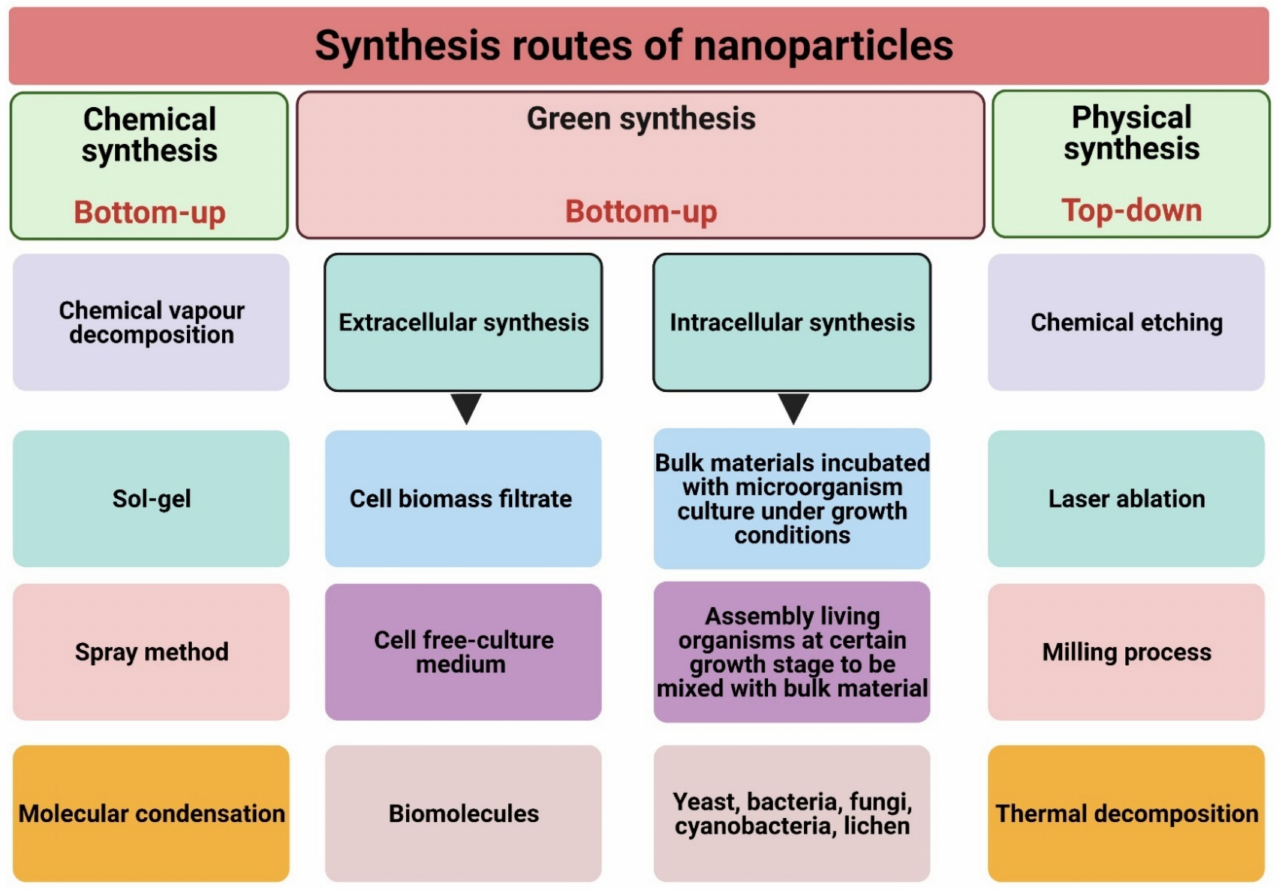
Figure 2. Synthesis routes of